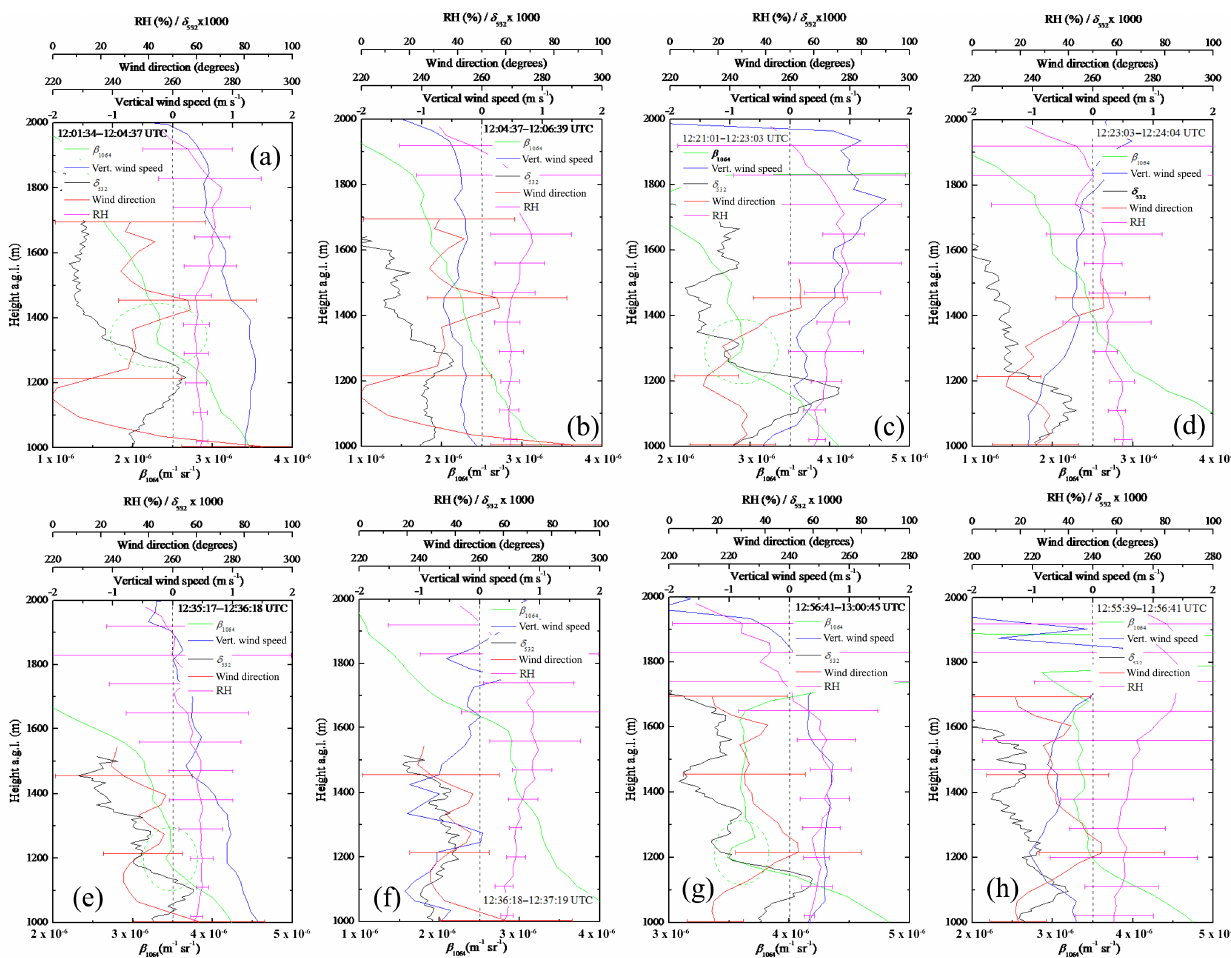
Figure 6. Vertical profiles of β 1064 , δ 532 and RH (as measured by BASIL) and the wind direction and vertical wind speed (as measured by the wind lidar) for eight consecutive up-draughts and down-draughts time intervals during the time period 12:00–13:00UTC on 18 April 2013: (a) 12:01:34–12:04:37UTC, (b) 12:04:37–12:06:39UTC, (c) 12:21:01–12:23:03UTC, (d) 12:23:03–12:24:04UTC, (e) 12:35:17– 12:36:18UTC, (f) 12:36:18–12:37:19UTC, (g) 12:56:41–13:00:45UTC and (h) 12:55:39–12:56:41UTC). Green-dashed ellipses highlight dark band features during the up-draught intervals. The up-draught and down-draught time intervals considered in the present figure are identified in Fig. 2 with red and blue